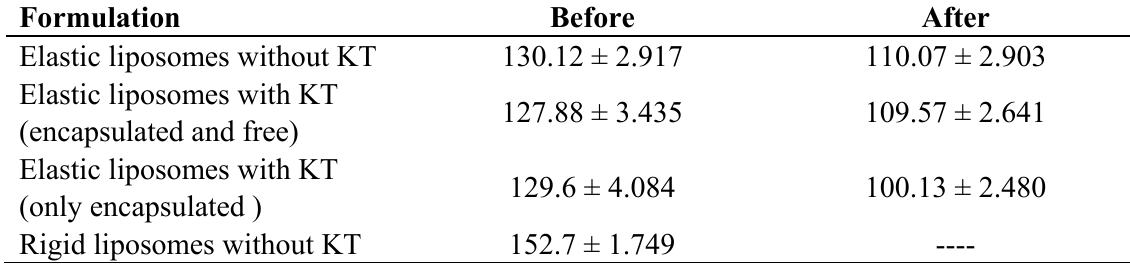
Table 1. Average size (nm) of elastic and rigid liposomes before and after manual extrusion through a polycarbonate membrane with a 50 nm pore size (n =